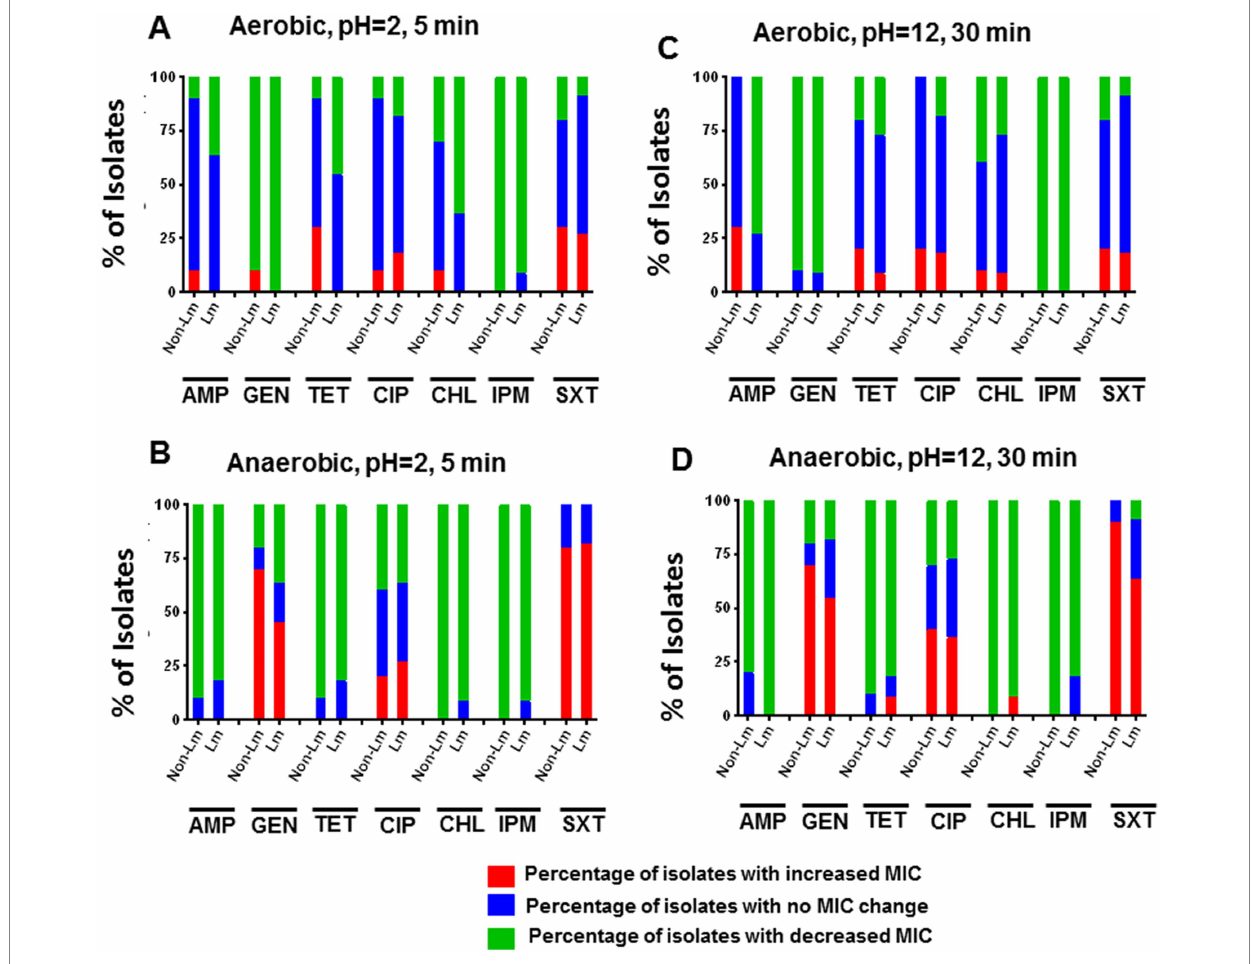
FIGURE 4 Changes in antimicrobial susceptibility in aerobic and anaerobic conditions after acid stress (pH 2, 5 min) and alkaline stress (pH 12, 30 min). AMP: ampicillin, GEN: gentamicin, TET: tetracycline, CIP: ciprofloxacin, CHL: chloramphenicol, IPM: imipenem, SXT: trimethoprim-sulfamethoxazole. (A) Change of MIC (increase/decrease) after acid stress compared with pre-stress (before stress) under aerobic incubation. (B) Change of MIC (increase/decrease) after acid stress compared with pre-stress (before stress) under anaerobic incubations. (C) Change of MIC (increase/decrease) after alkaline stress, compared with pre-stress (before stress) under aerobic incubation. (D) Change of MIC (increase/decrease) after alkaline stress, compared with pre-stress (before stress) under anaerobic